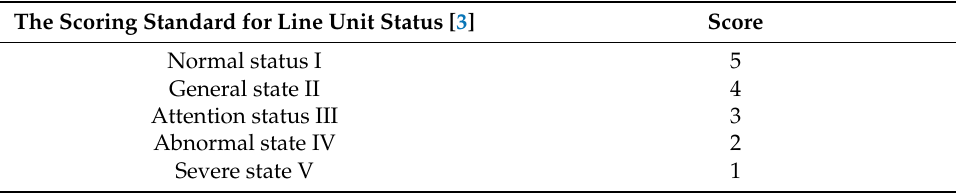
Table 3. The scoring standard for line unit status [3]. The Scoring Standard for Line Unit Status